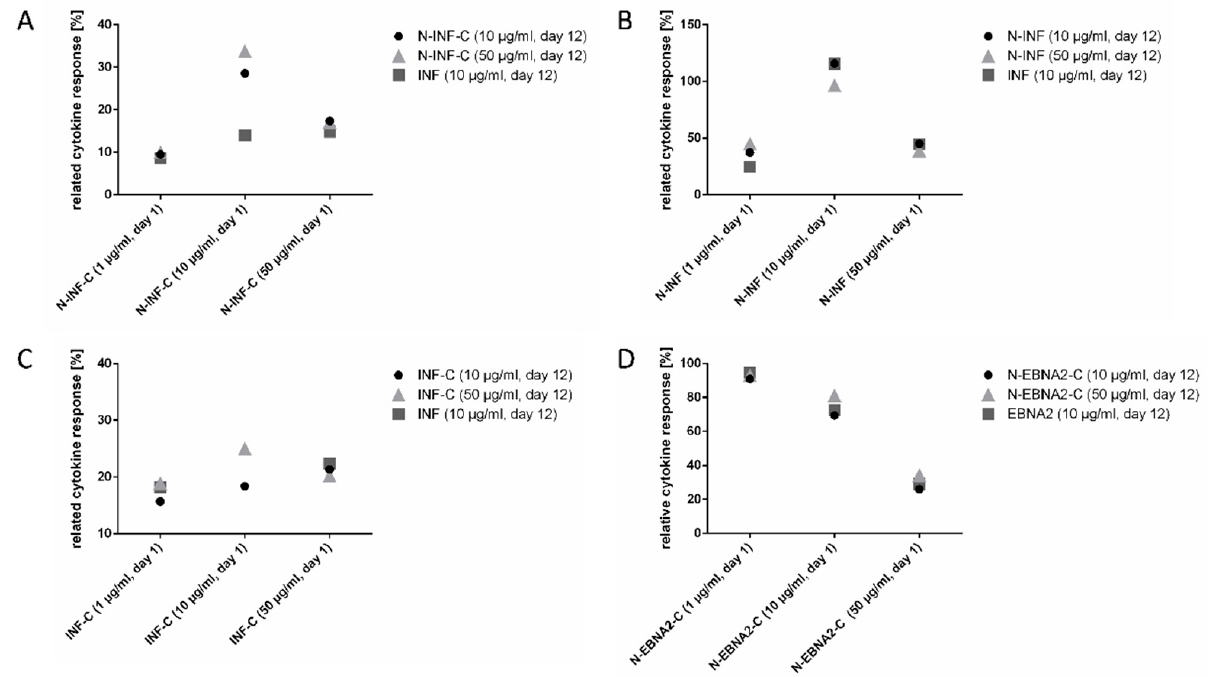
Figure 4. Identification of the optimal EP concentration for the read-out of viral-specific CD8 + and CD4 + cells after in vitro expansion. PBMCs were cultured with INF- or EBV-derived short peptides